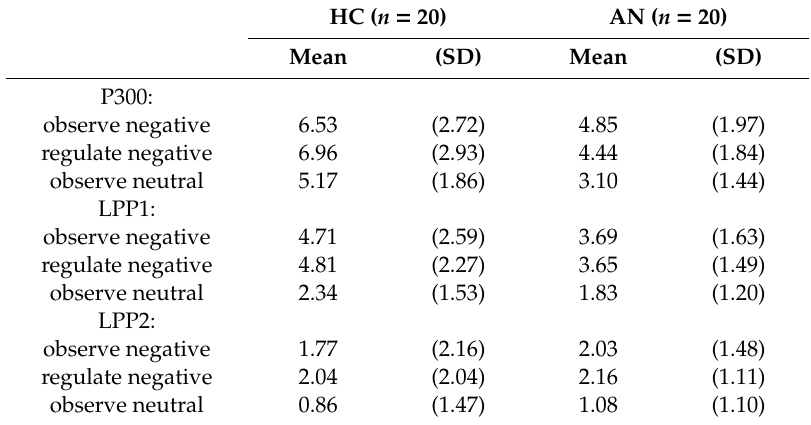
Table 3. Mean (SD) amplitudes ( µ V) of P300, LPP1 and LPP2 during the emotion regulation